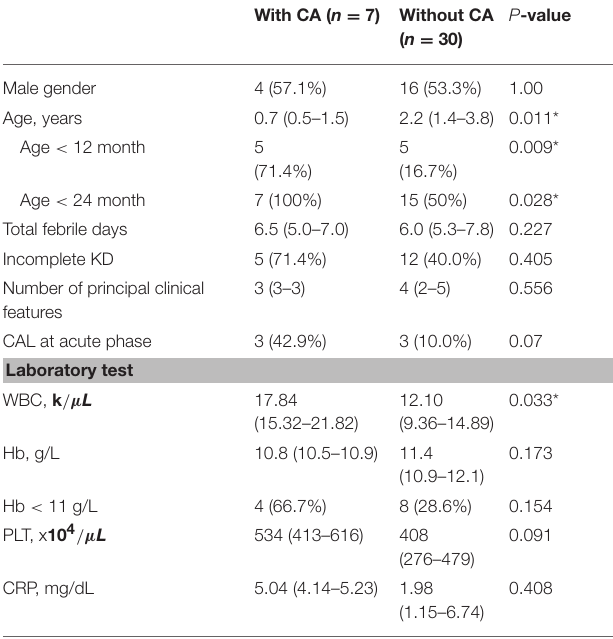
have IVIG therapies due to spontaneous defervescence (4/31), TABLE 2 | Comparison between spontaneous defervesced KD with and without